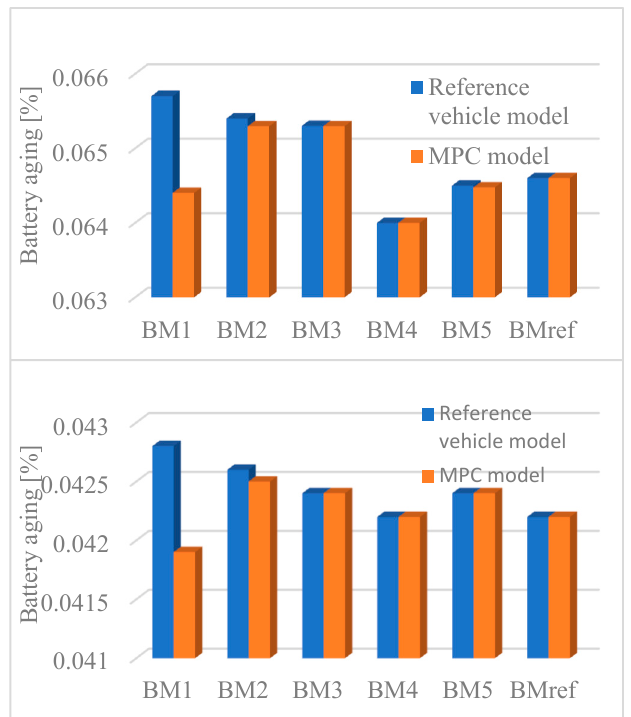
Figure 12. Battery aging comparison at the end of the two UDDS ( up ) and HWFET ( down ) drive cycles.